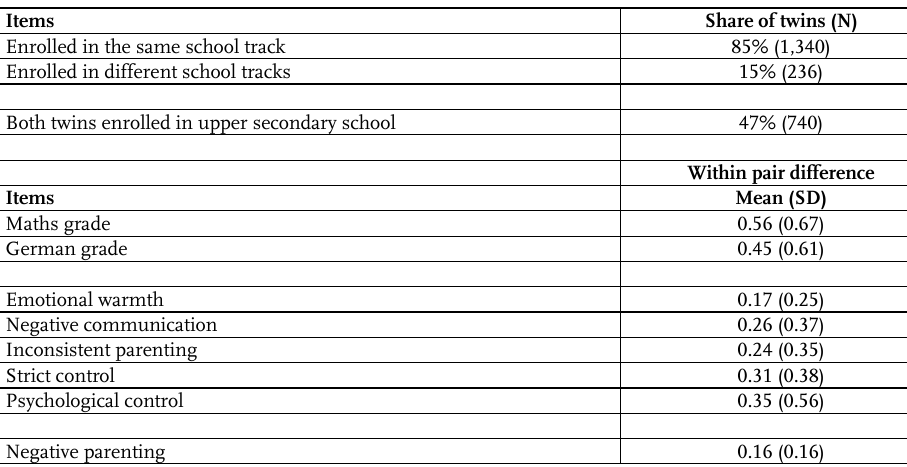
Table 4 : Overview of differences in track attendance, school grades, and the parenting twins experience (analytical